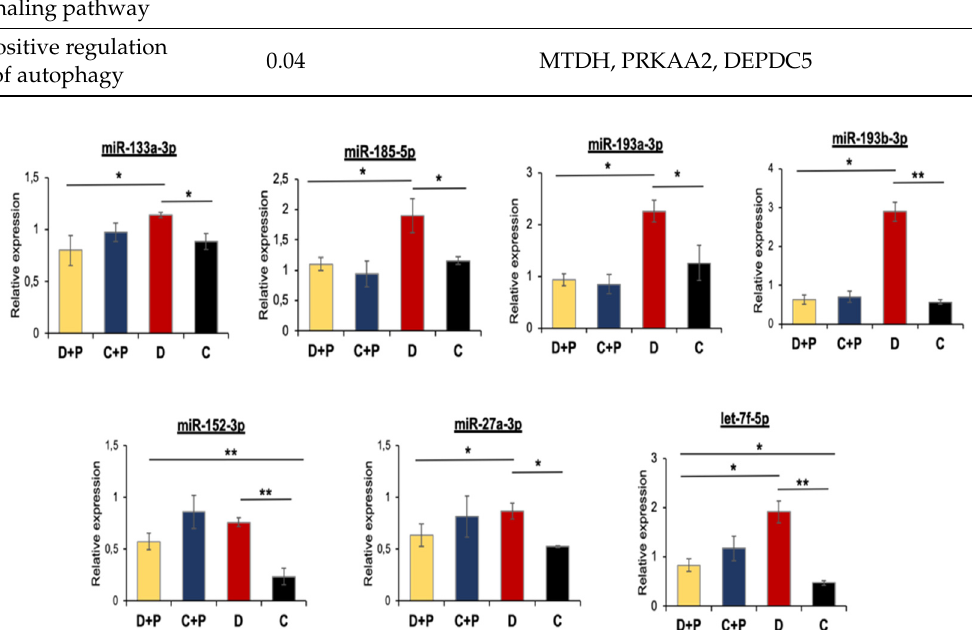
Figure 4. Transcriptomic miRNA expression validation. MiRNA expression was calculated through qRT-PCR relative to U6. Error bars indicate standard deviation calculated on at least three samples and three technical replicates per sample. Significance was calculated using a t -test between samples considering unequal variance between samples. * p ≤ 0.05; ** p ≤ 0.002. C: control; C + P: control + pargyline; D: diabetes; D + P: diabetes + pargyline.